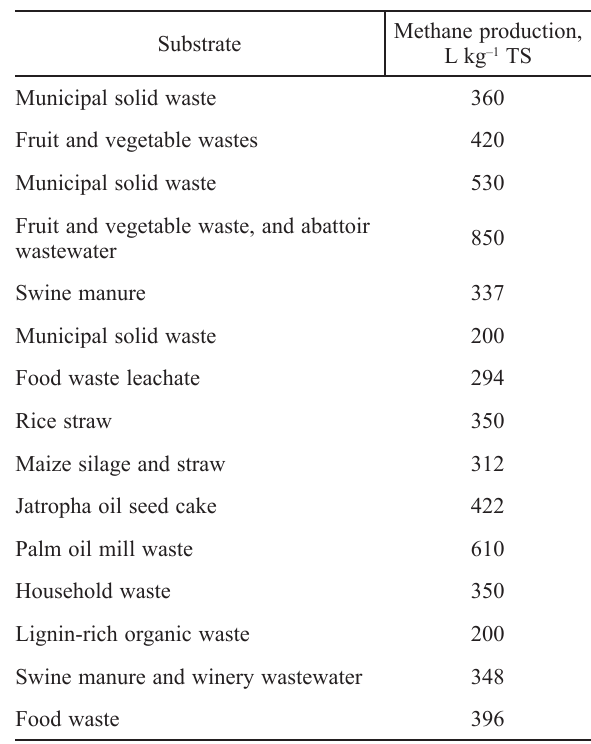
Table 2 – Methane yield recorded from anaerobic digestion of solid organic waste